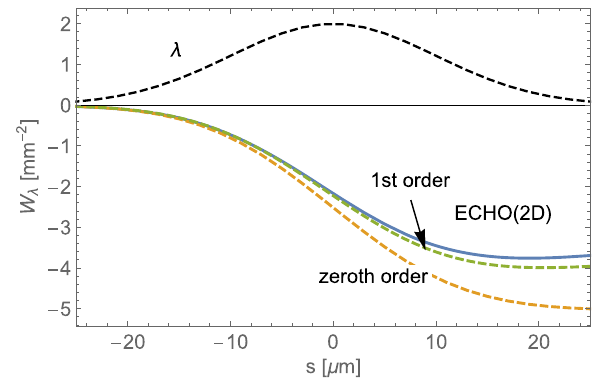
FIG. 4. Longitudinal bunch wake for a Gaussian beam on axis, ¼ 10 μ m, in a 2-m section of the RadiaBeam/LCLS with σ z dechirper. Given are the numerical results of ECHO(2D) (blue), and the analytical zeroth order (red) and 1st order results (green). The bunch shape λ ð s Þ with the head to the left is shown in